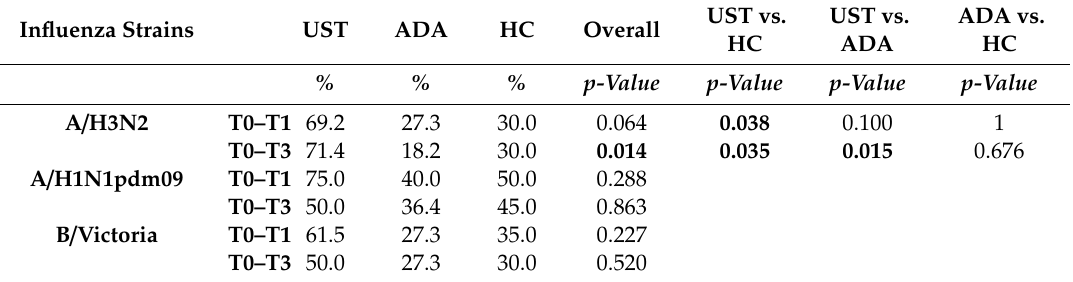
Table 3. Seroconversion rates per study group (% ≥ 4-fold increase).